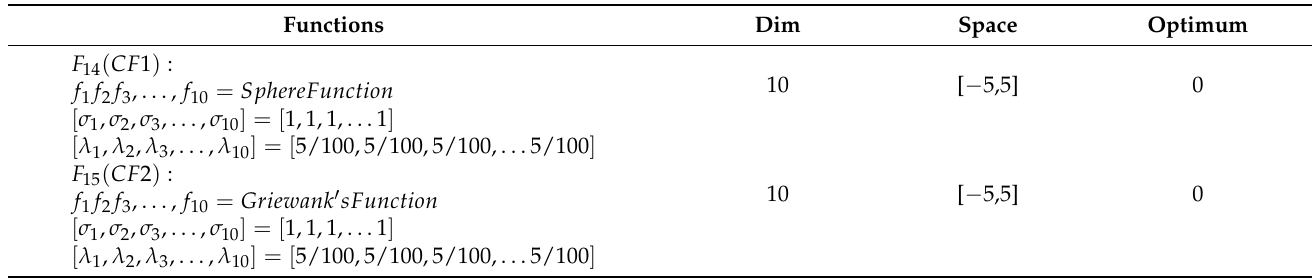
Table 3. Composite benchmark